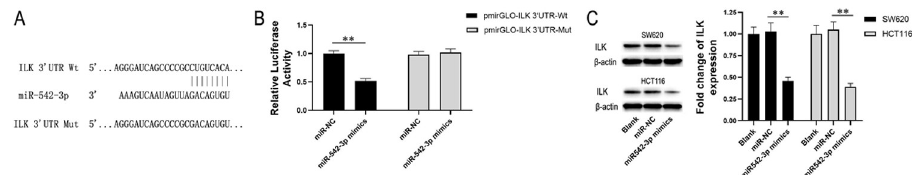
Fig 6. ILK is the target gene of miR-542-3p. (A) We first found the binding sites for miR-542-3p in ILK 3 ’UTR via bioinformatics analysis, (B) then ILK 3 ’UTR -Wt and ILK 3 ’UTR -Mut were designed, and the results of dual luciferase report assay revealed that the luciferase activity of the Wt reporter in the ILK-Wt+miR-542-3p mimics subset was significantly reduced compared to 3 other subsets. (C) The effect of transfected miR-542-3p mimic on the expression of the ILK protein was detected by WB. ILK protein was downregulated in miR-542-3p mimics subsets both in SW620 and HCT116. Three subsets were designed and compared to blank or miR-NC, ILK in up-regulated miR-542-3p expressed lower. Black represents pmirGLO-ILK 3 ’UTR -Wt and grey represent pmirGLO-ILK 3 ’UTR -Mut in histograms. The right picture is the quantitative analysis of the left one. Black represents SW620 and grey represents HCT116 in histograms. � P < 0.05 and �� P < 0.01.